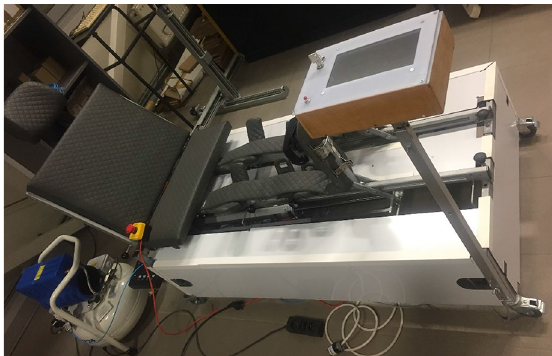
Figure 2. Rehabilitation device.